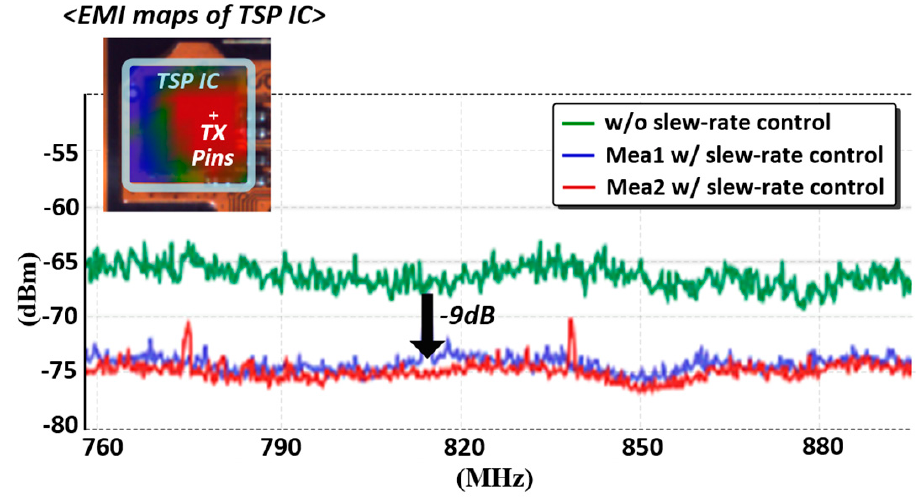
Figure 21. PSD of radiated TSP driving signals in the GSM frequency band.